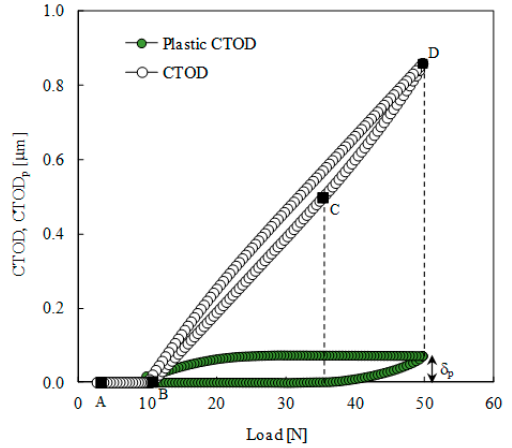
Figure 6. Evolution of Crack Tip Opening Displacement (CTOD) with load (a 0 = 24 mm; plane stress).